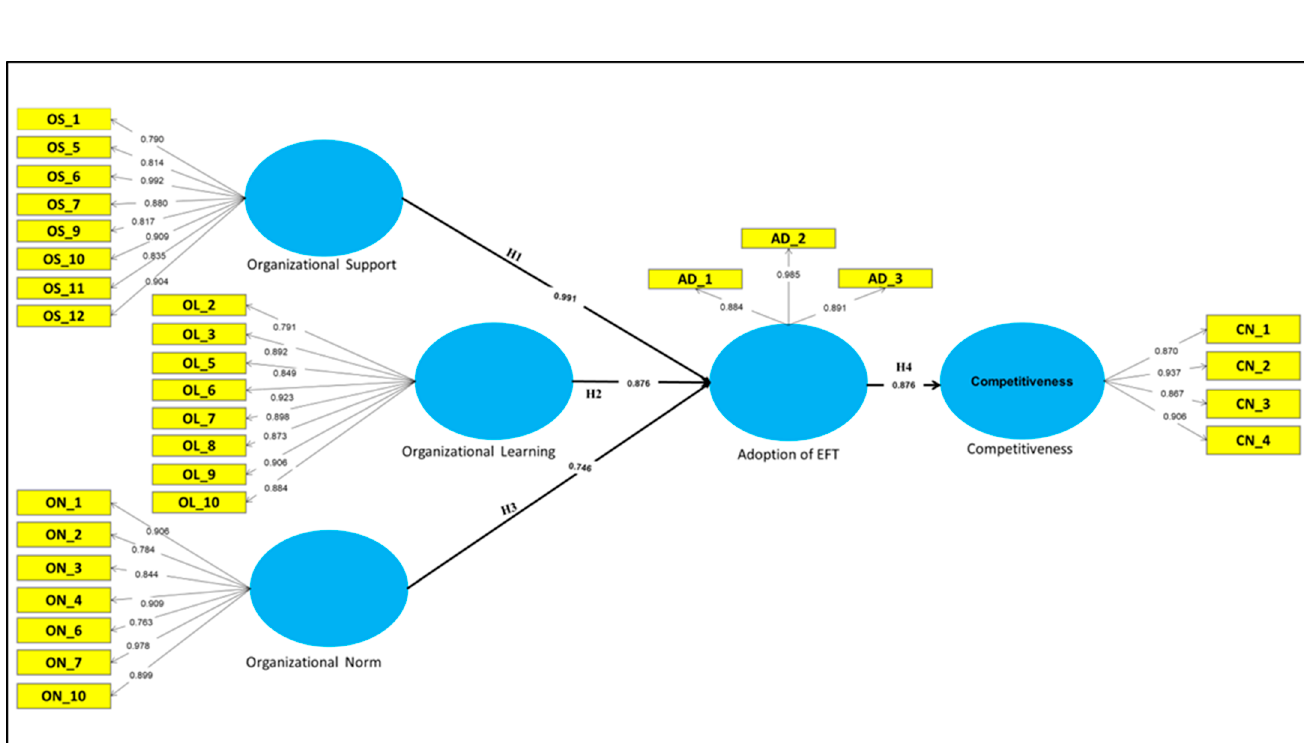
Figure 2. PLS-SEM results of the proposed model.